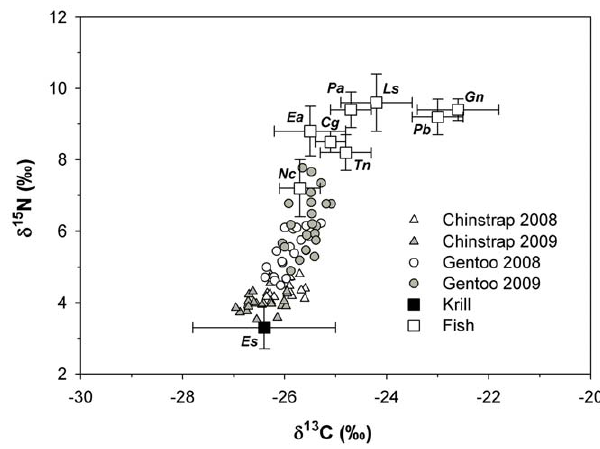
Figure 1. Isotope signatures of penguin chick feathers in relation to nine common prey species. Values are presented ( d 13 C and d 15 N; mean 6 SD). Chick feather values are presented after correction for dietary isotopic discrimination (Polito et al. 2011). Prey species abbreviation are Krill: Es ( Euphausia superba ), Fish: Ea ( Electrona antarctica ), Cg ( Champsocephalus gunnari ), Gn ( Gymnoscopelus nicholsi ), Ls ( Lepidonotothen squamifroms ), Nc ( Notolepis coatsi ), Pa ( Pleura- gramma antarcticum ), Pb ( Protomyctophum bolini ), and Tn ( Trematomus newnesi ).